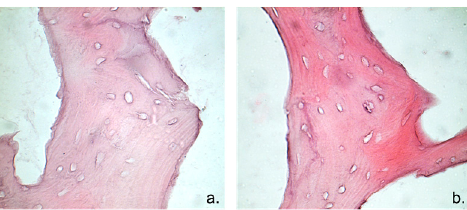
Figure 2. Histological images of two sections ( a and b ) of the patella bone. In both sections, details of bone trabeculae show well-preserved bone tissue with well-recognizable osteocyte lacunae and no signs of destructive foci (magni fi cation